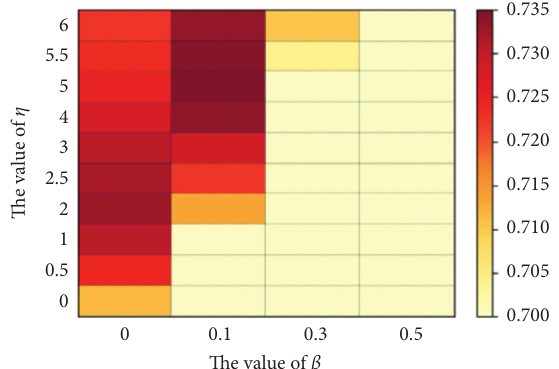
Figure 10: The accuracy of different parameter estimates on the regression model.